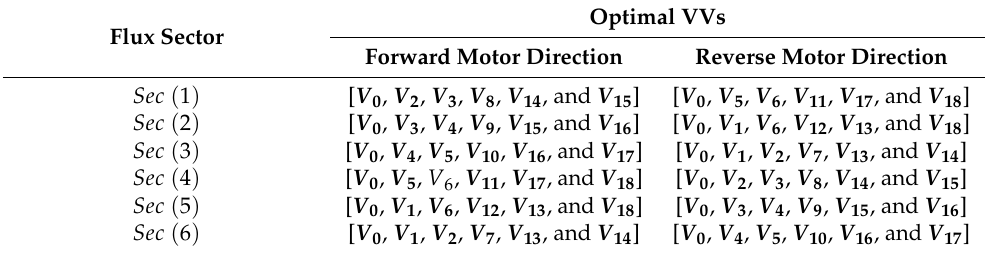
Table 2. Optimal VVs for each flux